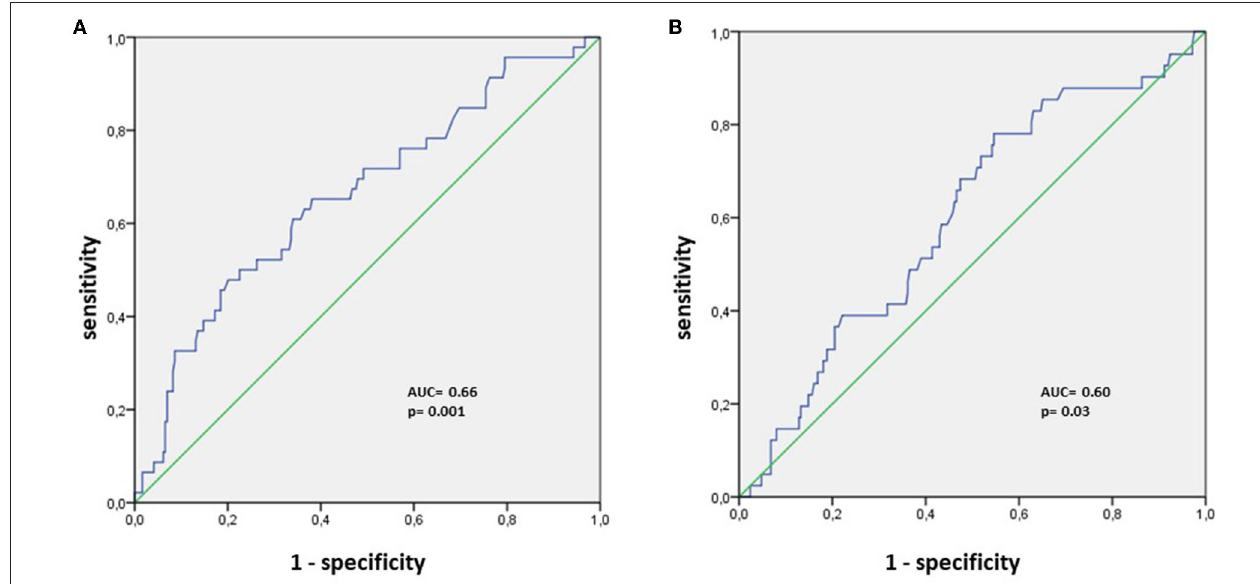
FIGURE 3 | ROC analysis for endothelial function amelioration and (A) chest pain recovery, (B) palpitations